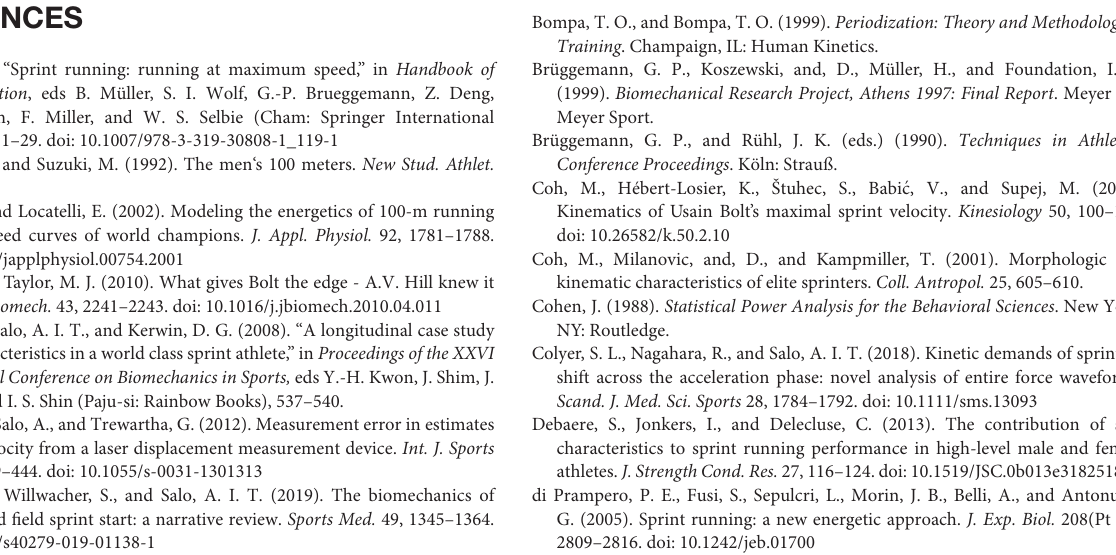
Supplementary Figure 1 | Bland-Altman plots for TSI speed vs. Laveg (left), TSI step length (middle), and TSI step time vs. OptoGait, respectively. Systematic differences (solid line) and 95% limits of agreement (dashed lines) are